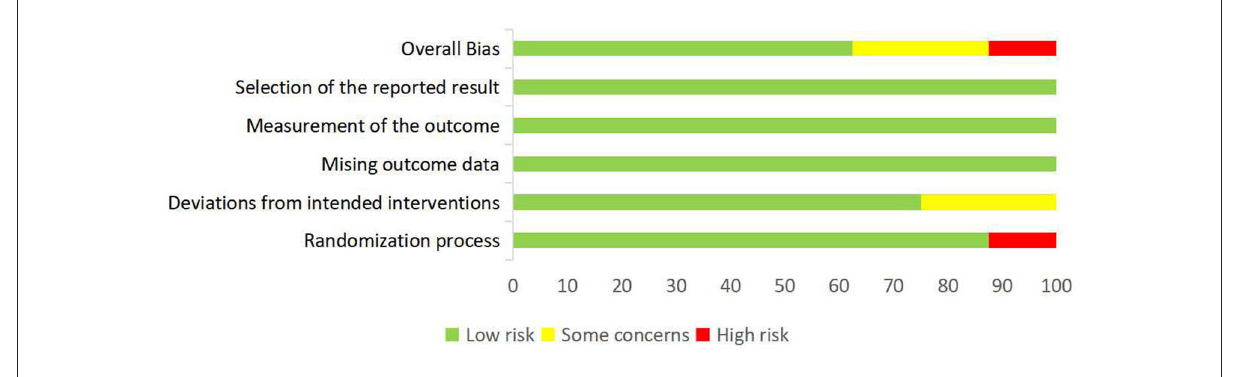
FIGURE2 Risk of bias summary.